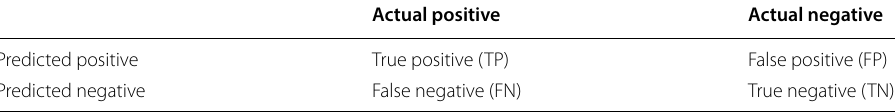
Table 10 Confusion